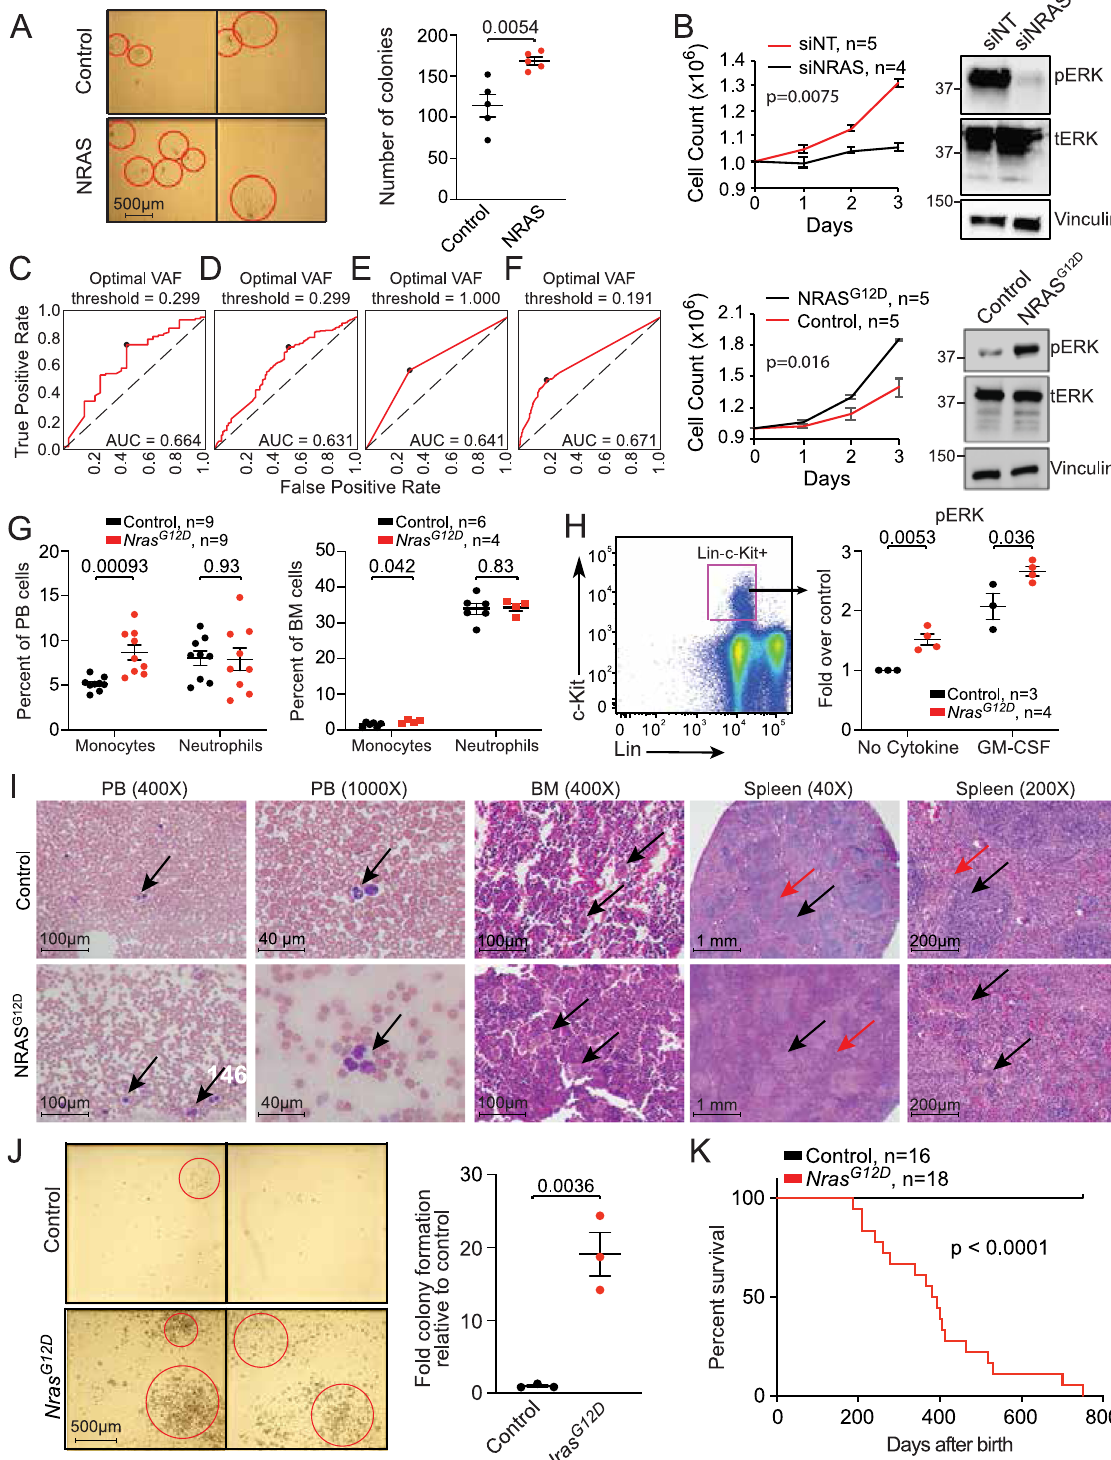
expressed in RAS pathway-mutated pCMML as (1) mitotic cell cycle process (e.g. WEE1, PLK1, PLK2 ), (2) cell cycle G2/M checkpoint regulation (e.g. WEE1, AURKA, CHEK1 ), (3) chromosomal segregation (e.g. CDC45, RPA3 ), and (4) mitotic cell cycle phase transition (e.g. PLK1 ; Supplementary Fig. 4D). Focusing on protein coding, targetable genes downstream of the oncogenic RAS pathway, we selected PLK1 , a conserved kinase